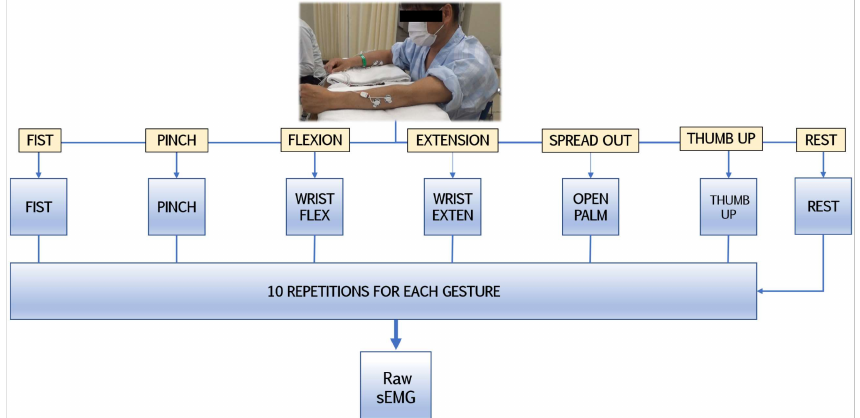
Figure 1. The experimental protocol for detecting sEMG signals during